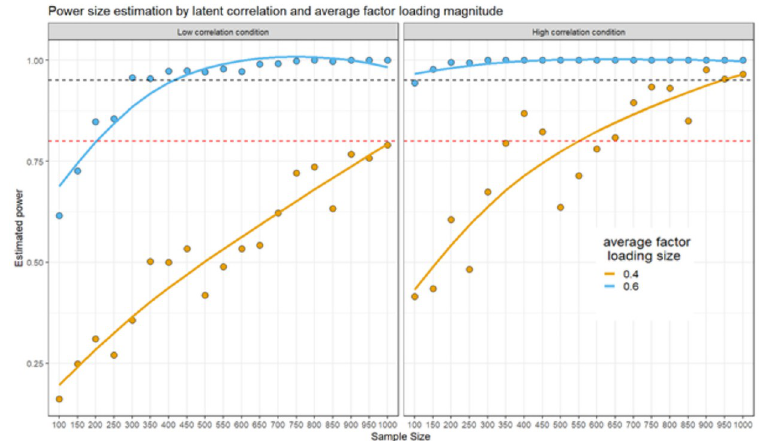
Fig 6. Simulations for power analysis for the SEM model including six latent correlated